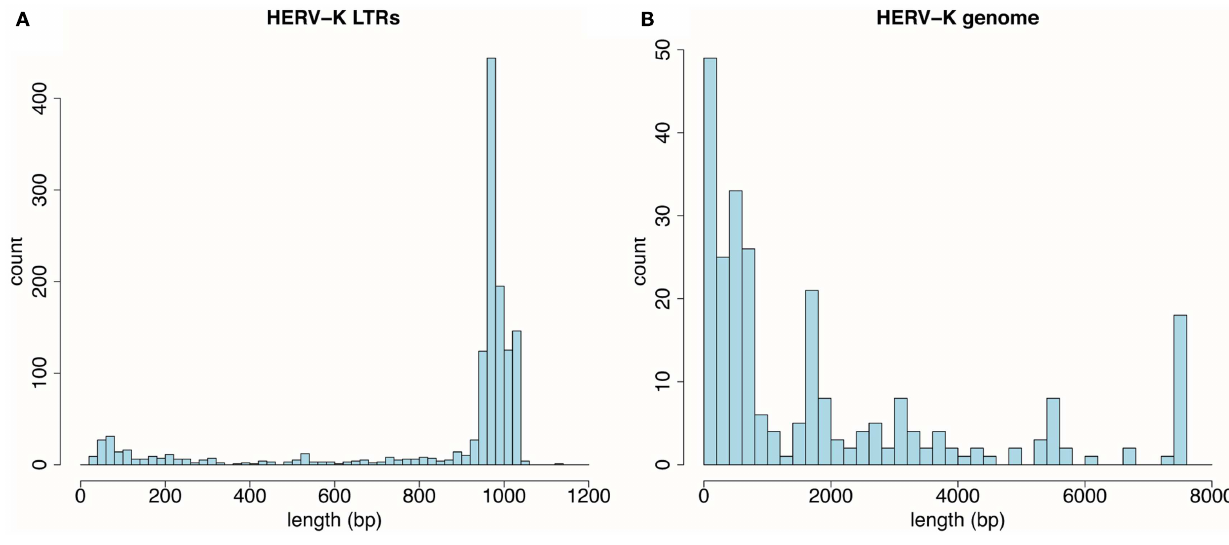
FIGURE 1 | Distribution by size of HERV-K components detected by RepeatMasker in the UCSC Genome Browser, GRCh37/hg19 human genome assembly . (A) Thousand three hundred and sixty-one HERV-K LTR